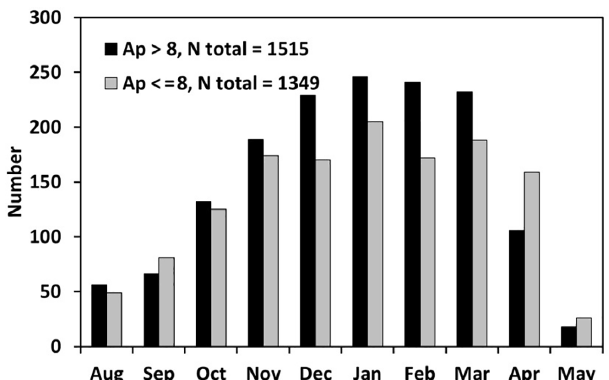
Figure 3. The number of measurements per month during the geo- magnetic activity years (Ap>8) and quiet years (Ap< =